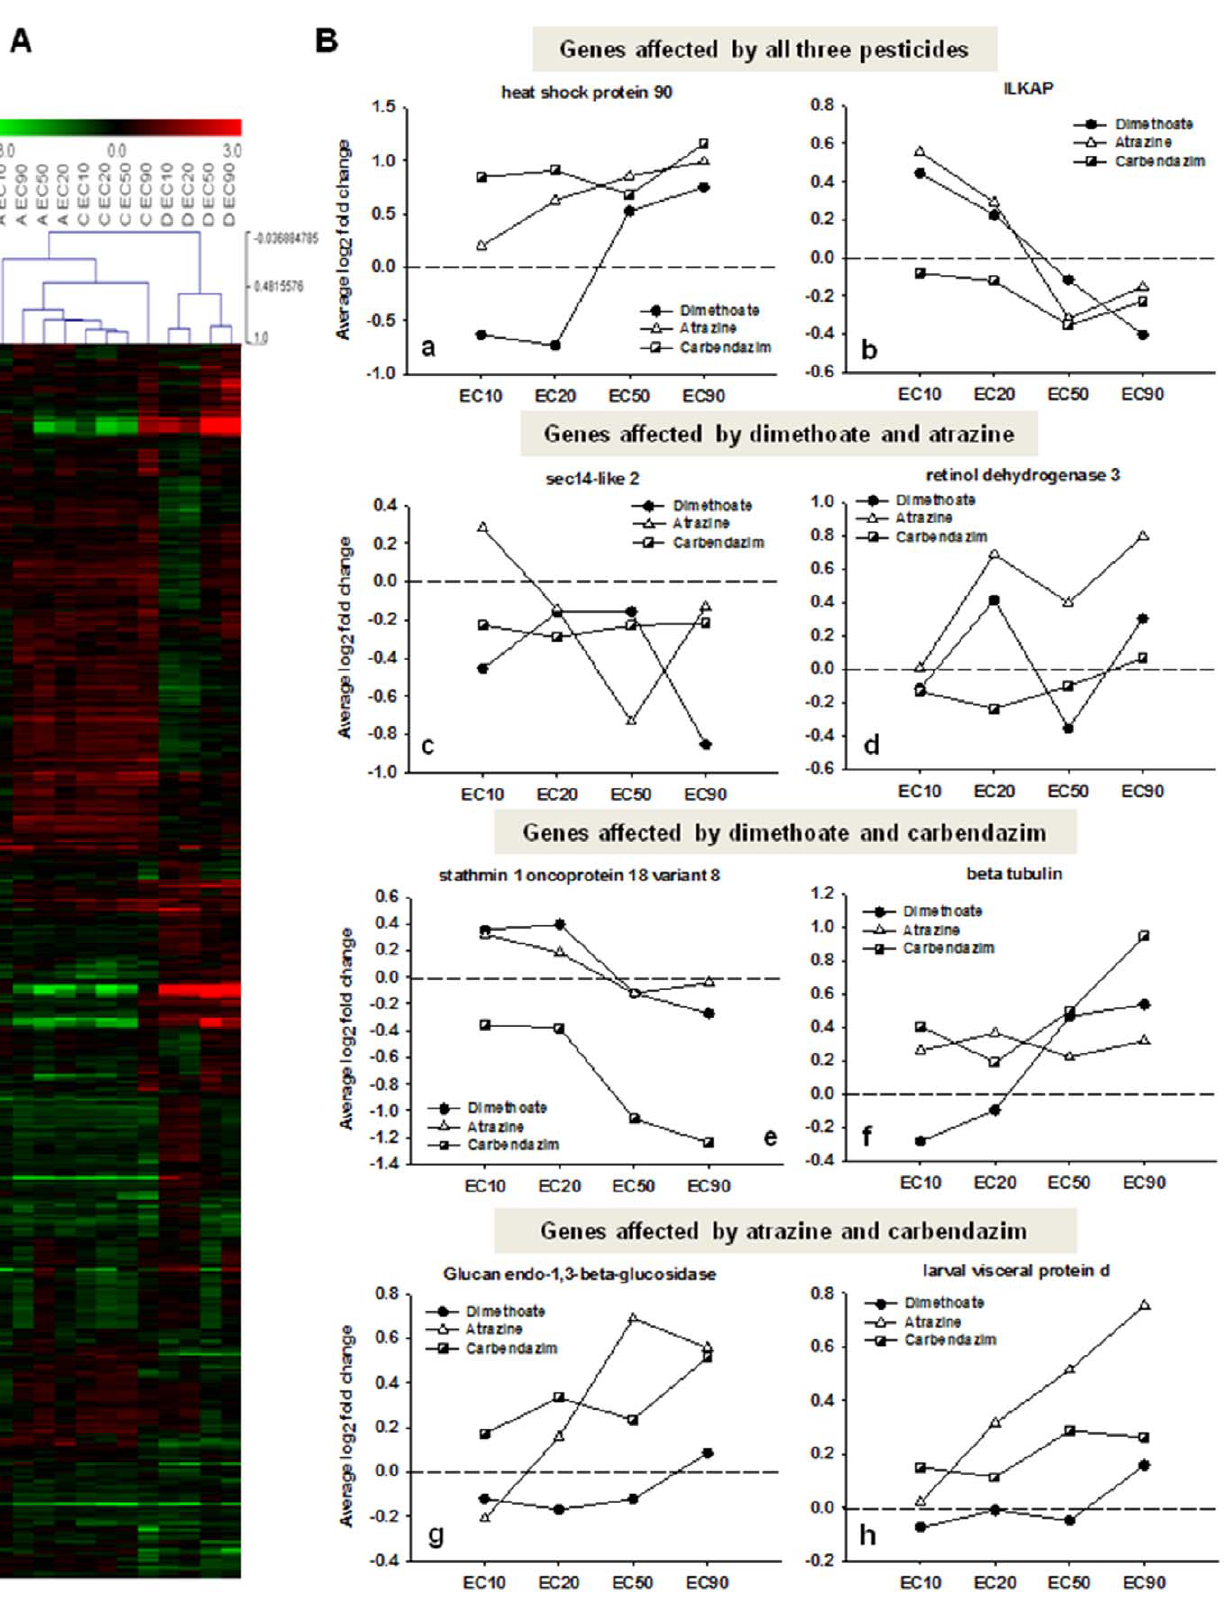
Figure 4. Clustering analysis of all samples and expression of transcripts affected by more than one pesticide. A - Heat map and hierarchical clustering of samples (Pearson’s uncentered) based on the differentially expressed genes (two sample t -test, p , 0.05) in Enchytraeus albidus exposed to four concentrations of dimethoate, atrazine and carbendazim (reproduction EC 10 , EC 20 , EC 50 and EC 90 ). B – Expression behavior of